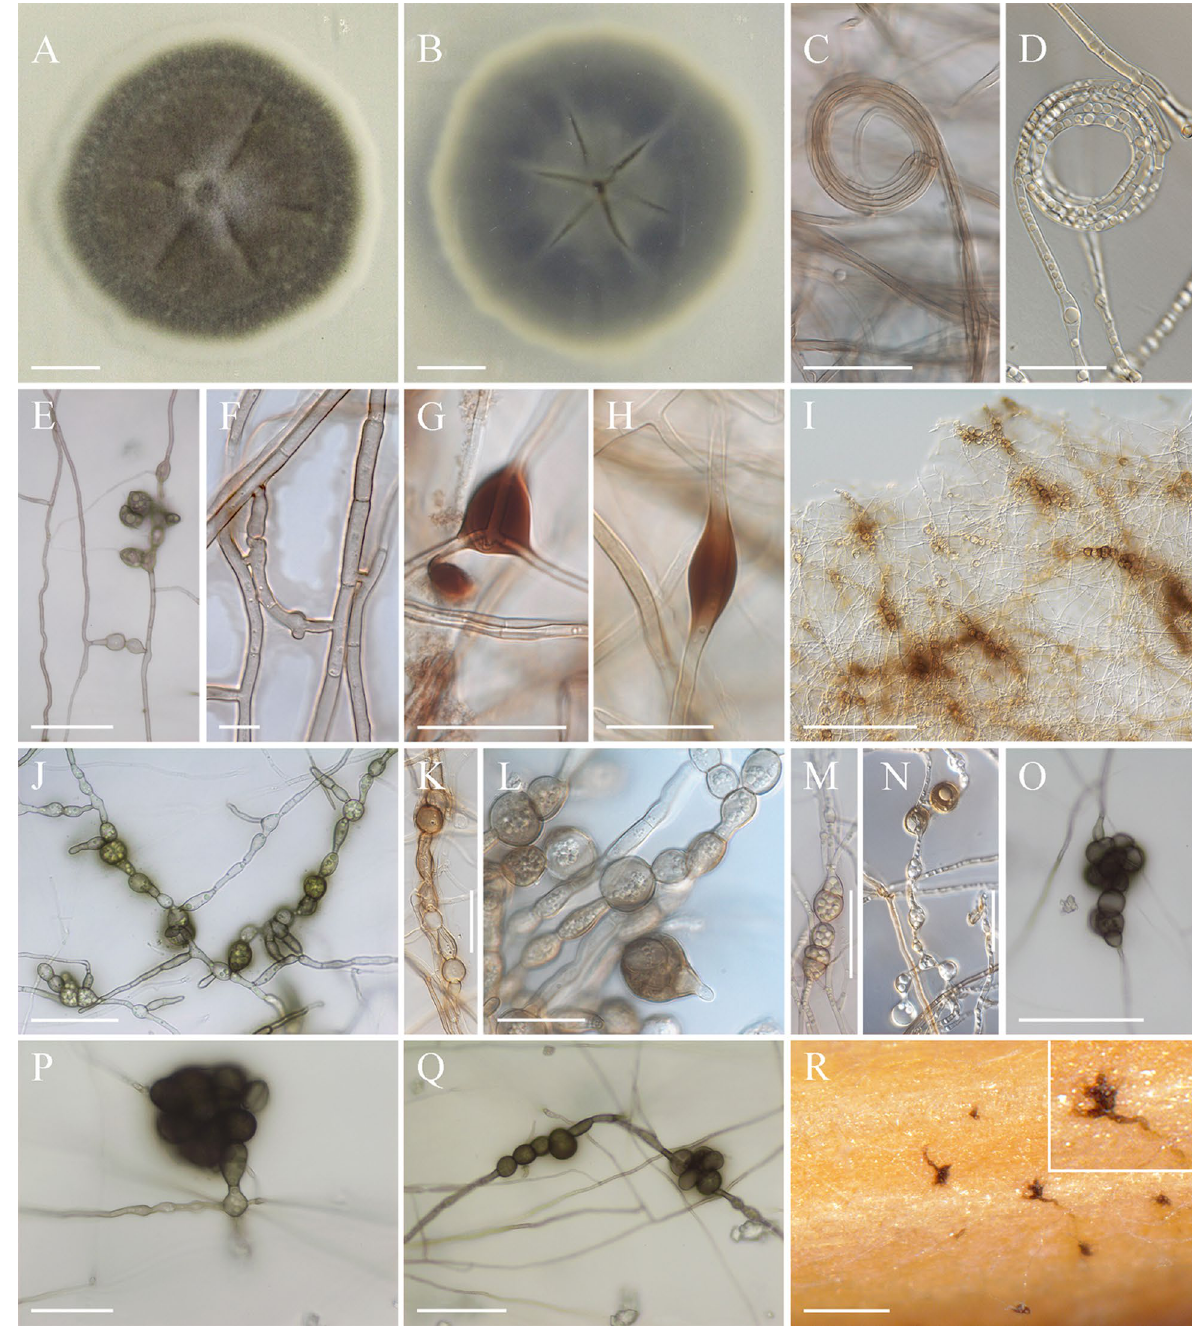
Fig. 7 Micrographs of Polydomus karssenii . a , b Isolate growing on PDA, top view ( a ) and bottom view ( b ). c , d Fungal growth and formation of coiling hyphae. e , f Hyphal anastomosis. g , h Formation of pigmented hyphal vesicle‑like structures. i – n Fungal growth and formation of moniliform hyphal cells ( j , k ) and chlamydospore‑like structures ( l – n ). o – r Formation of highly melanised microsclerotia structures, in culture media ( o – q ), on wheat straw ( r ). A, B, C, F: from PDA; I, K, L, M: from PDA1/3; J: from PDA 1/6; E, O, P, Q: from CaCO 3 ; G, H: from CZA; N: from MEA 1%.